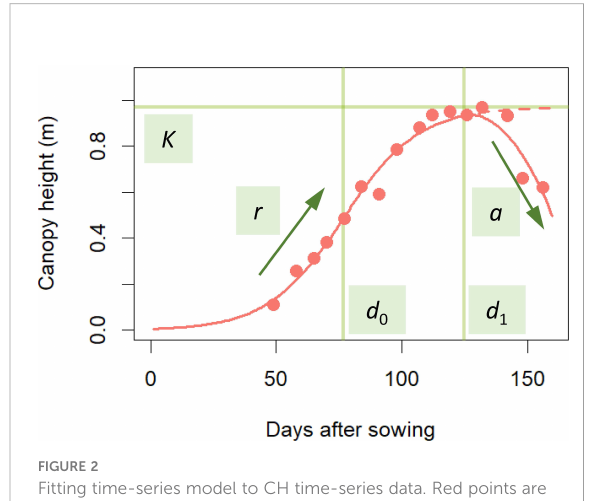
FIGURE 2 Fitting time-series model to CH time-series data. Red points are CH data obtained by UAV. The time-series model applied to the data is the red S-shaped curve. The model was prescribed by 5 parameters: K , the maximum saturation value; r , growth rate; a , CH decrease in the late growth phase; d 0 , time point at the highest growth rate; d 1 , time point at maximum CH. This curve was described in equation